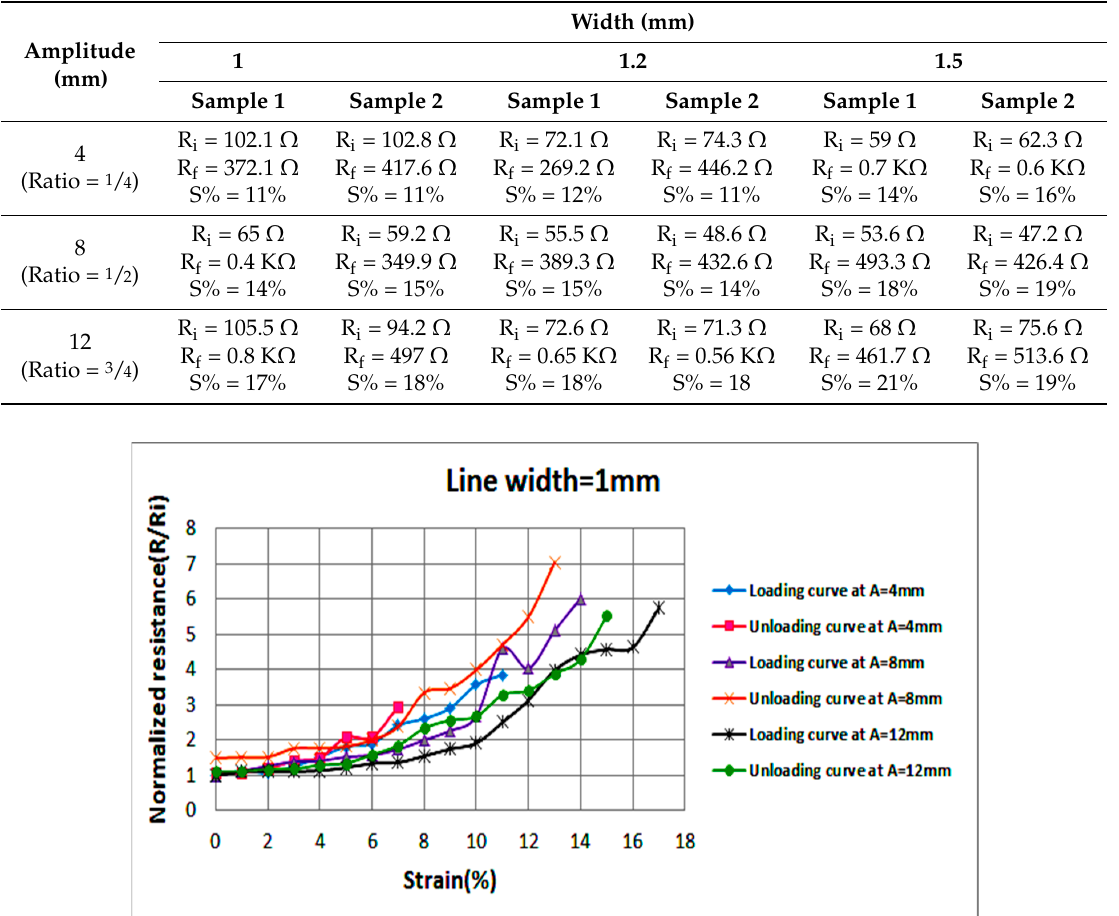
Figure 8. Average normalized resistances of two sinusoidal samples at a line width of 1 mm and various amplitudes as the applied strain increases (loading) and decreases (unloading).